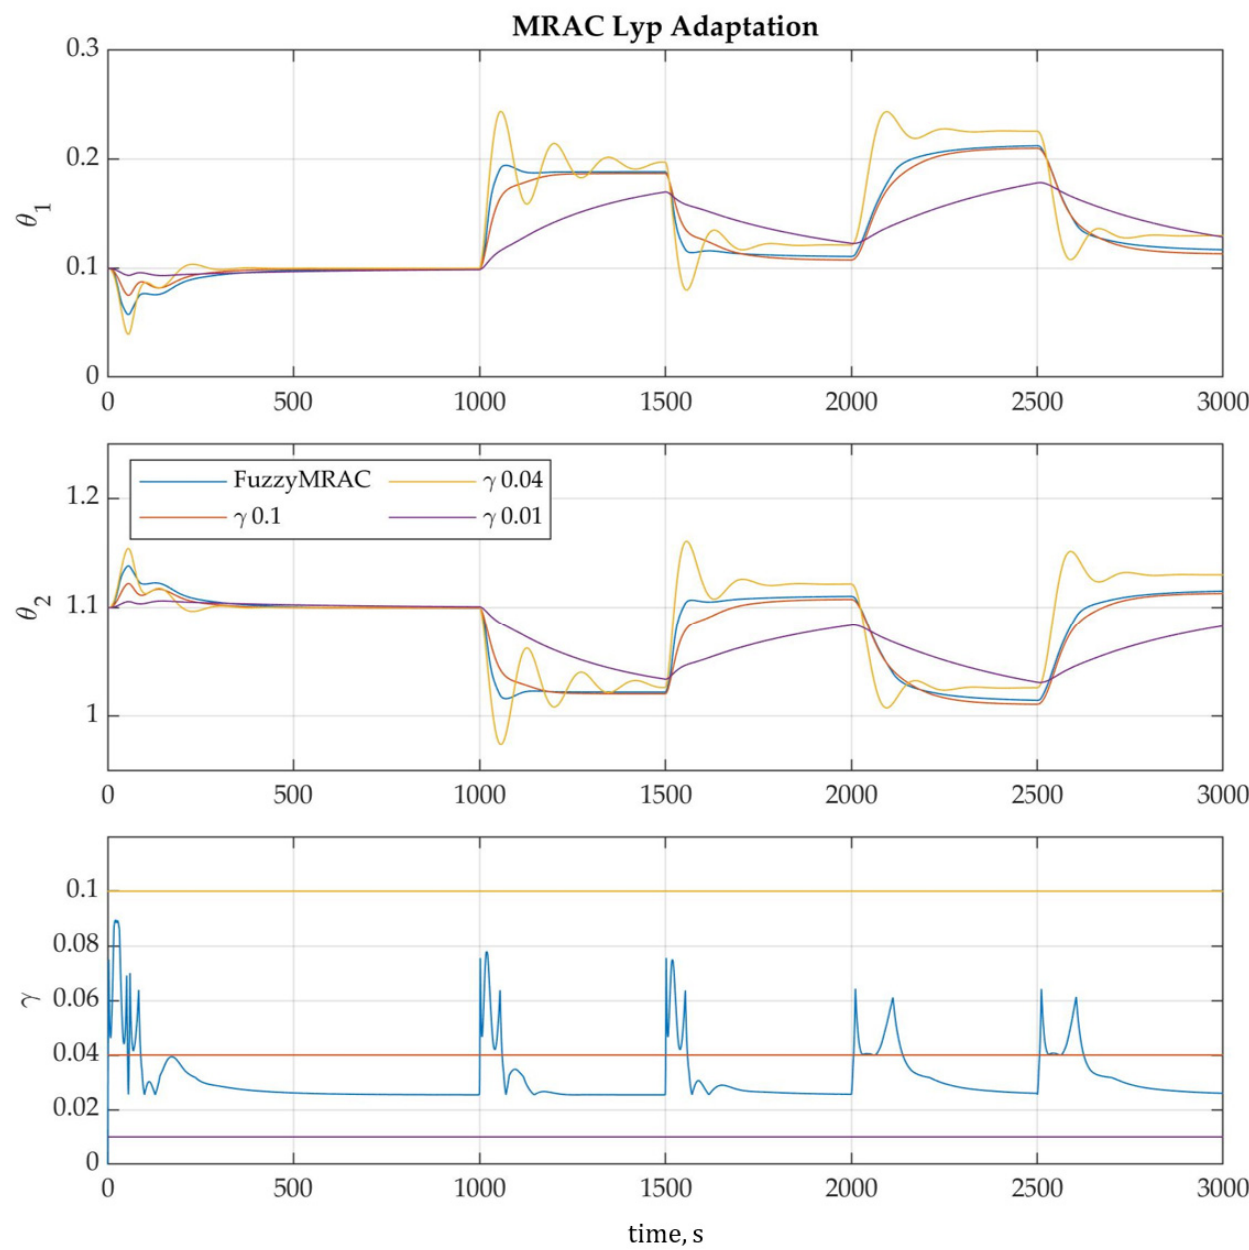
Figure 10. Lyapunov rule fuzzy MRAC, MRAC (adaptation rate 0.01, 0.04 and 0.1) parameter adaptation θ 1 , θ 2 , and γ .